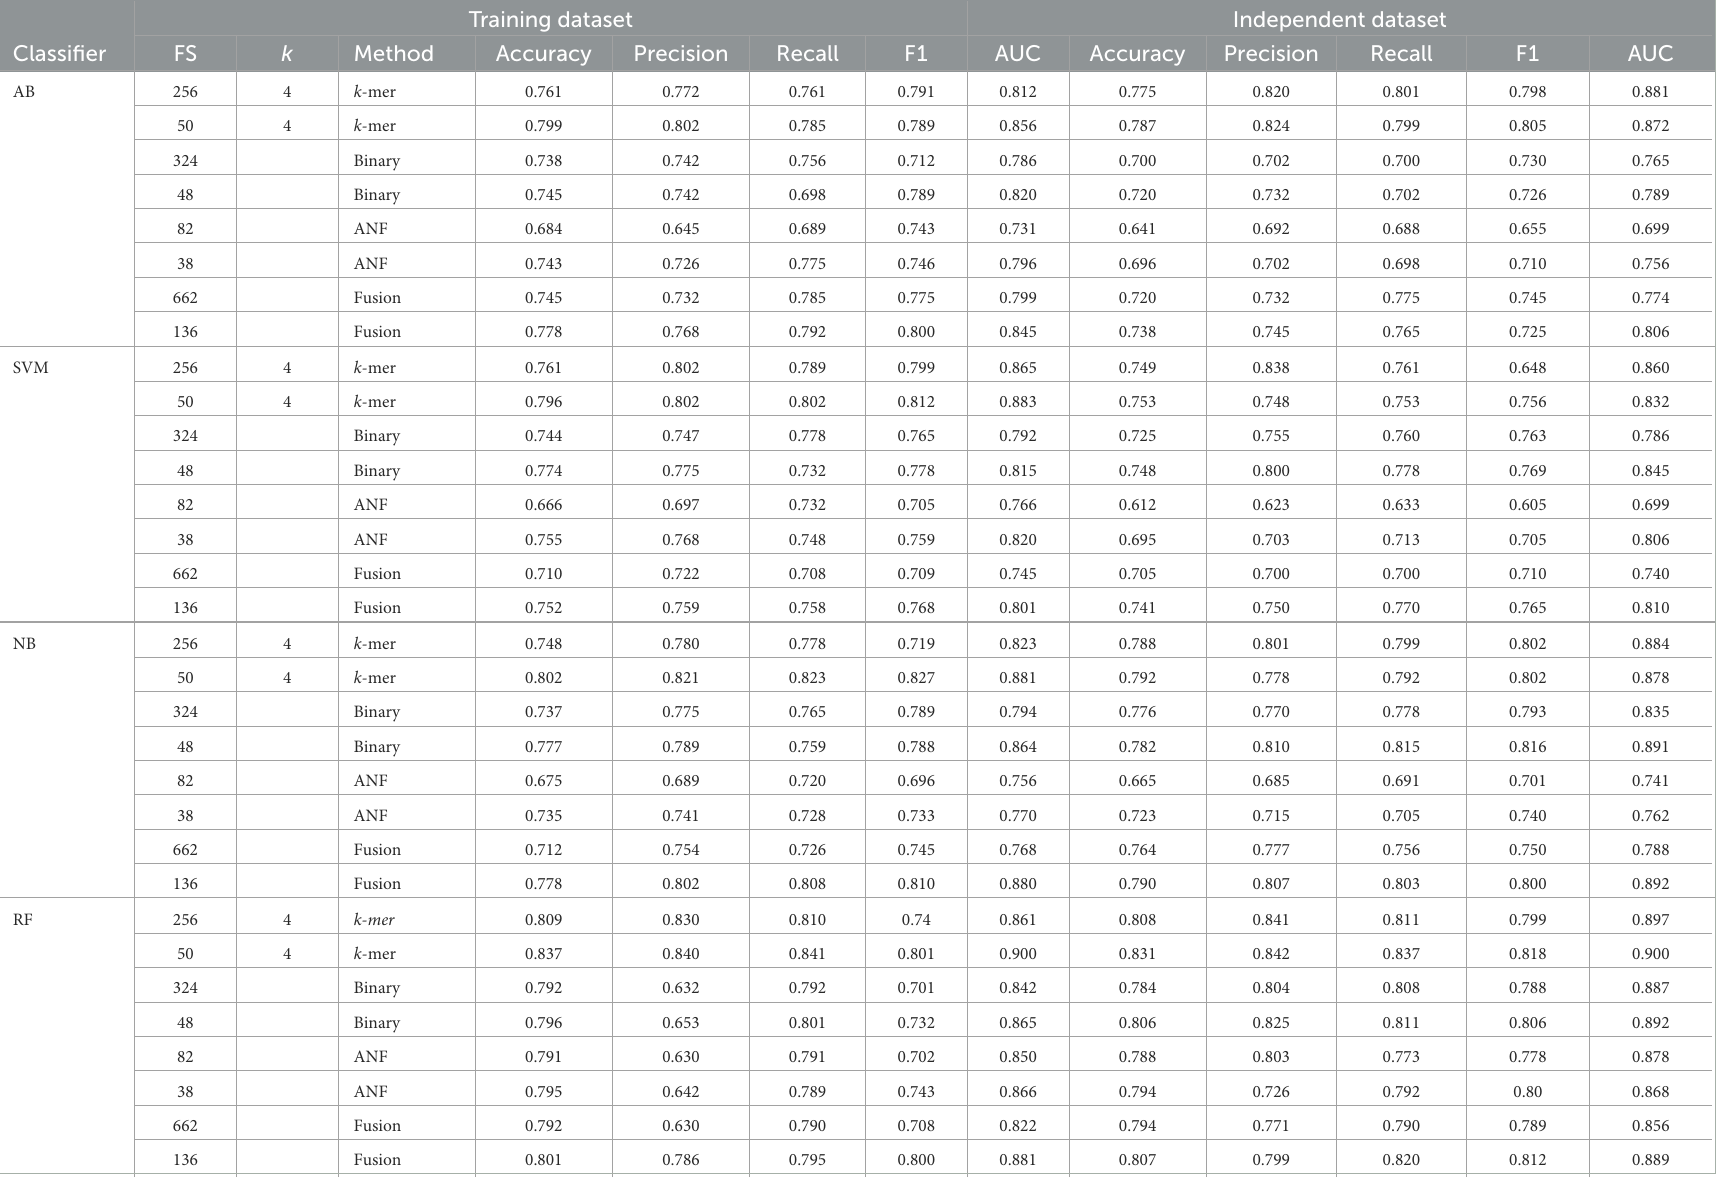
TABLE 2 Performance of models using different classifiers on the training and independent